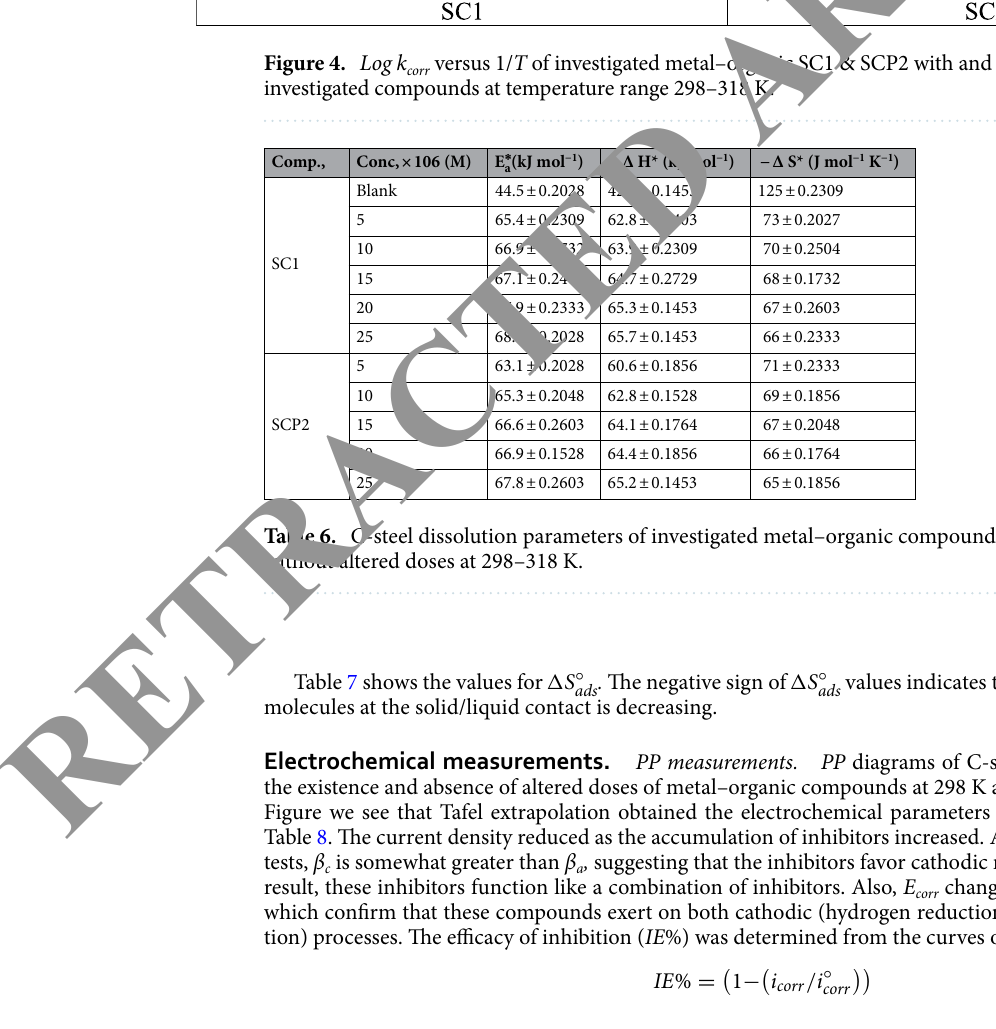
Table 8. The current density reduced as the accumulation of inhibitors increased. According to the results of the tests, β c is somewhat greater than β a , suggesting that the inhibitors favor cathodic rather than nodic action. As a result, these inhibitors function like a combination of inhibitors. Also, E corr change slightly (less than ± 85 mV) which confirm that these compounds exert on both cathodic (hydrogen reduction) and anodic (metal dissolu- tion) processes. The efficacy of inhibition ( IE %) was determined from the curves of polarization as in Eq. (9):